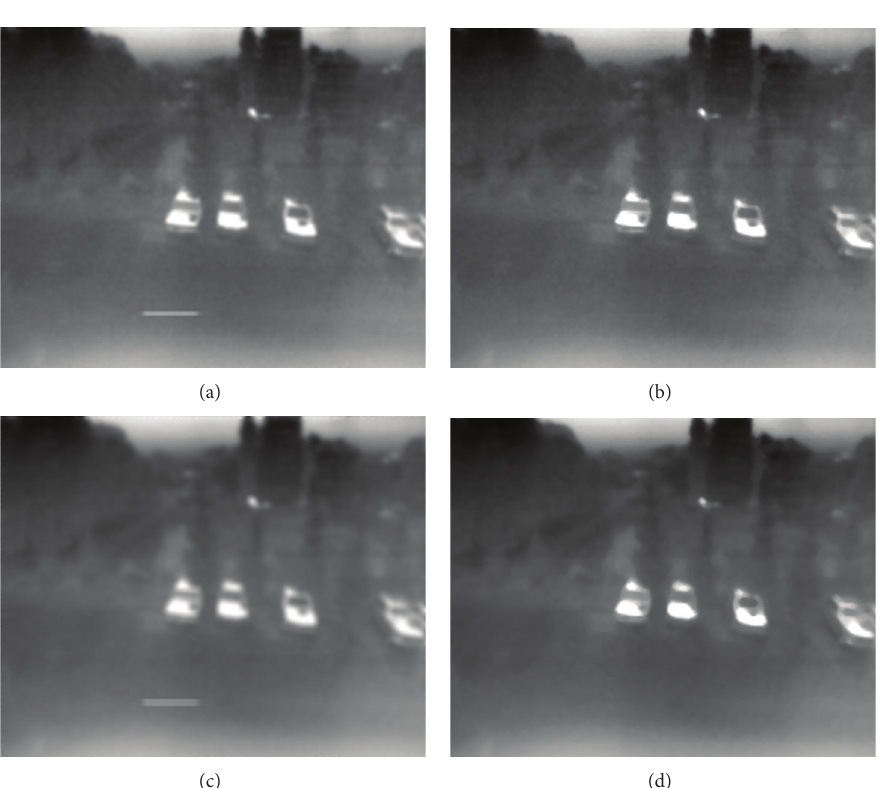
Figure 11: (a) Denoised KUT28 WSS (3 × 3 averaging filter), (b) denoised KUT26 WSS (3 × 3 median filter), (c) denoised KUT28 WSS (5 × 5 averaging filter), (d) and denoised KUT28 WSS (5 × 5 median filter).